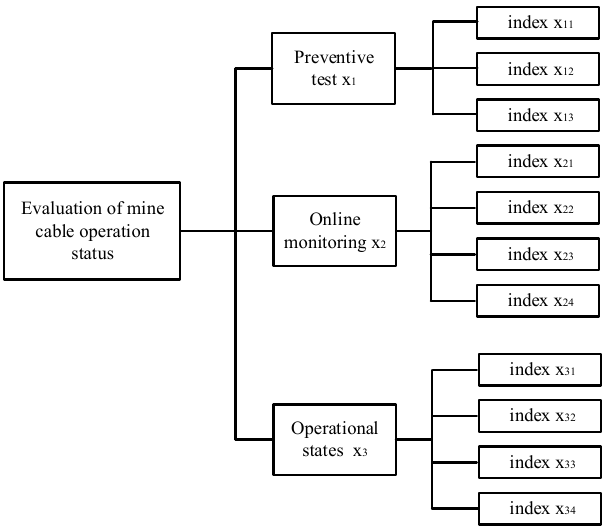
Figure 1. Operation status evaluation model for mining XLPE cables